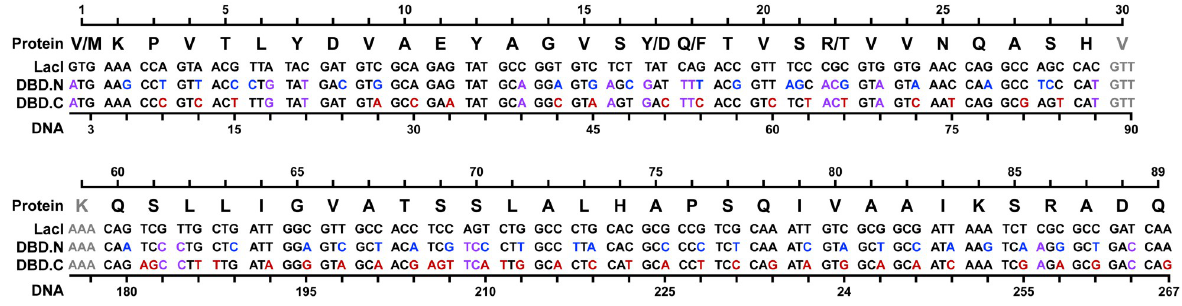
Fig 2. Single-chain tandem repeat repressor sequence. A comparison of the redesigned LacI DNA sequences produced by TReSR (residues 1–29 and 60–89) encoding the N- and C-terminal duplicated tandem repeat DBDs (DBD.N and DBD.C respectively), for the single-chain DBD repressor scDBD DFT/DFT . Synonymous mutations produced by TreSR are highlighted, with those unique to DBD.N in blue, those unique to DBD.C in red, and those shared by both DBD.N and DBD.C in purple.